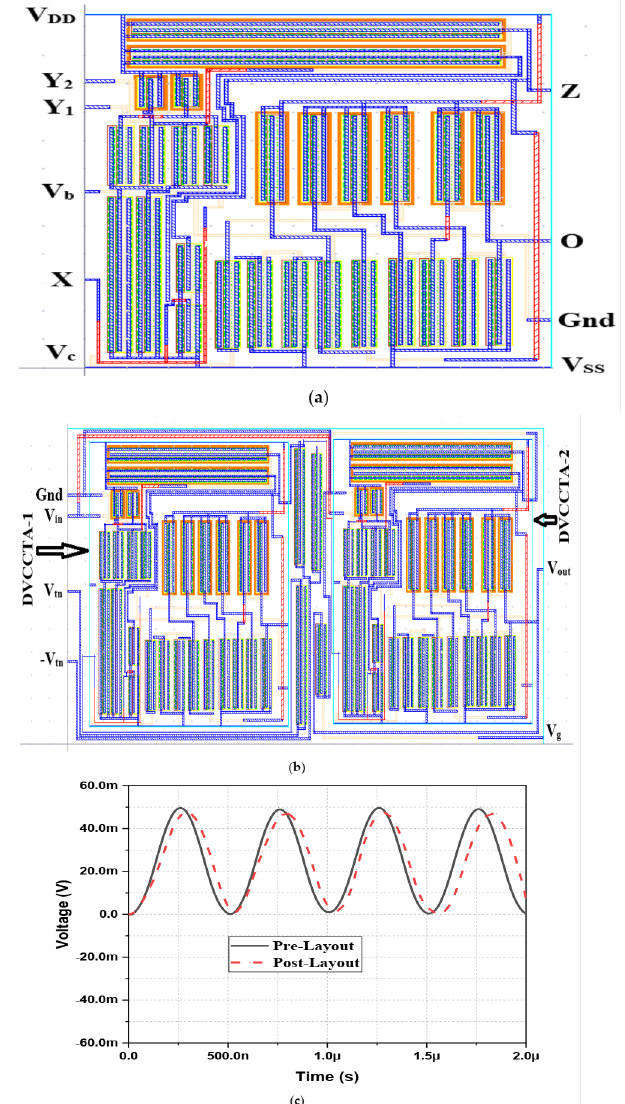
Figure 13. Layout of the proposed rectifier circuit ( a ) Layout of DVCCTA ( b ) Layout of the full-wave rectifier ( c ) Transient response of pre and post-layout